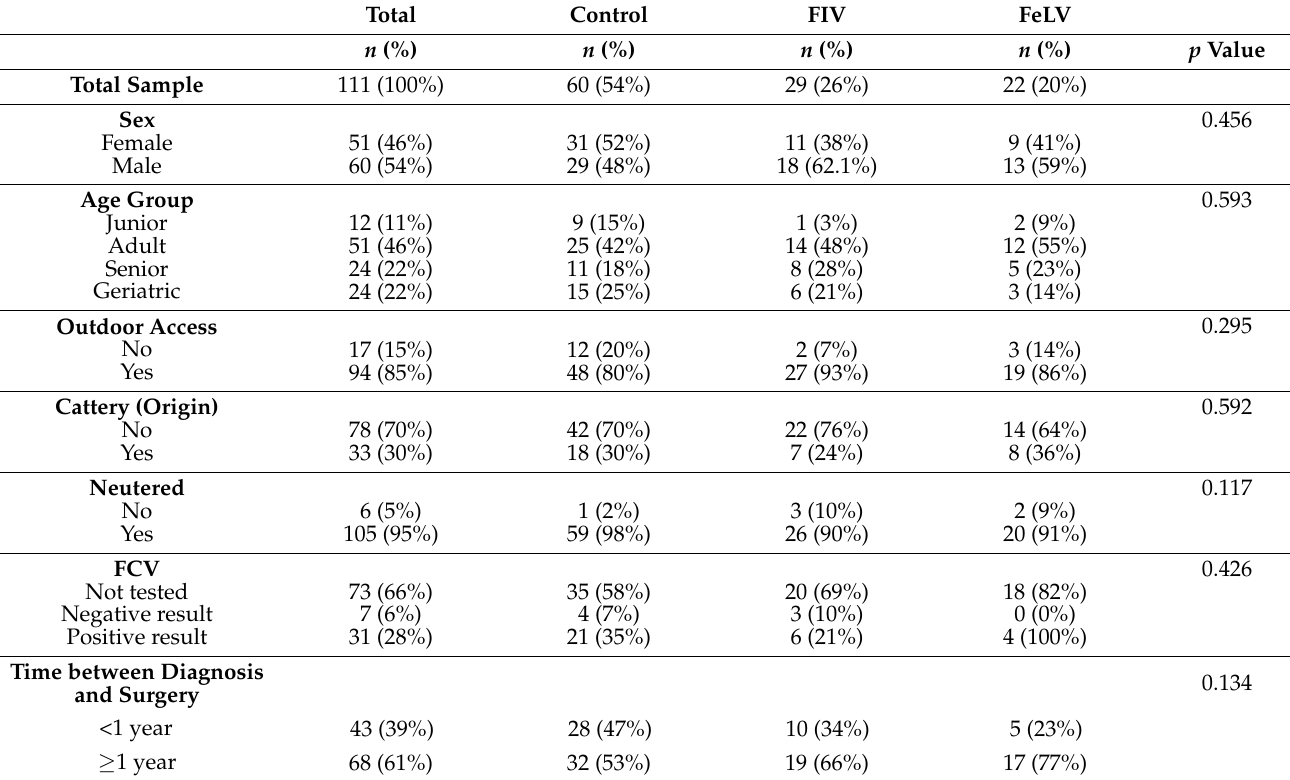
Table 2. General characterization of the retrospective